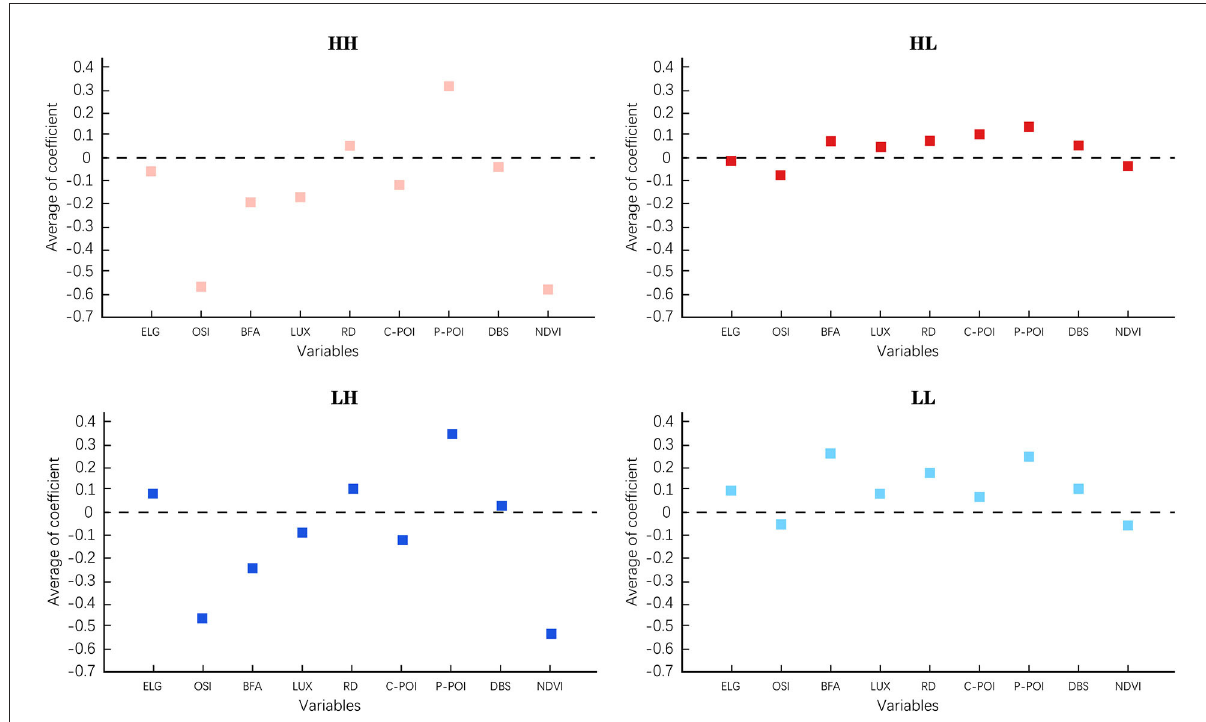
FIGURE6 Average of built environment coefficient (ELG, Eye-level greenery; OSI, Open sky index; BFA, Building floor area; LUX, Land-use mix; RD, Road density; C-POI, Commercial POI; P-POI, Public service POI; DBS, Distance to bus